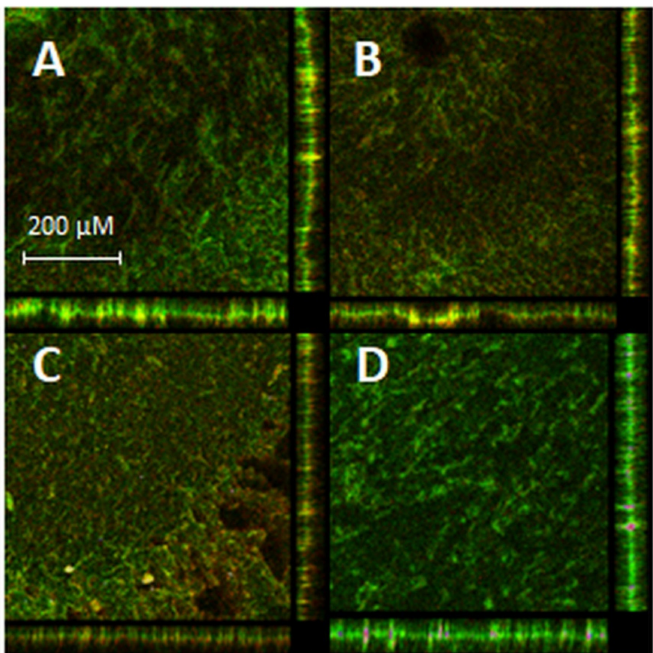
Figure 5. CLSM assessment of E. faecalis -treated biofilms. Biofilms were grown for 24 h on coupons, exposed to RB (5 µ M) for 15 min and irradiated twice with a dose of green light at 7.95 J/cm 2 . Biofilms were stained with the BacLight Live/Dead kit. Panel ( A ): biofilm exposed to aPDI (RB); panel ( B ): aPDI (RB)-treated biofilm exposed to 5 × MIC of CIP; panel ( C ): aPDI (RB)-treated biofilm exposed to 3 × MIC of STR; panel ( D ): control (nontreated